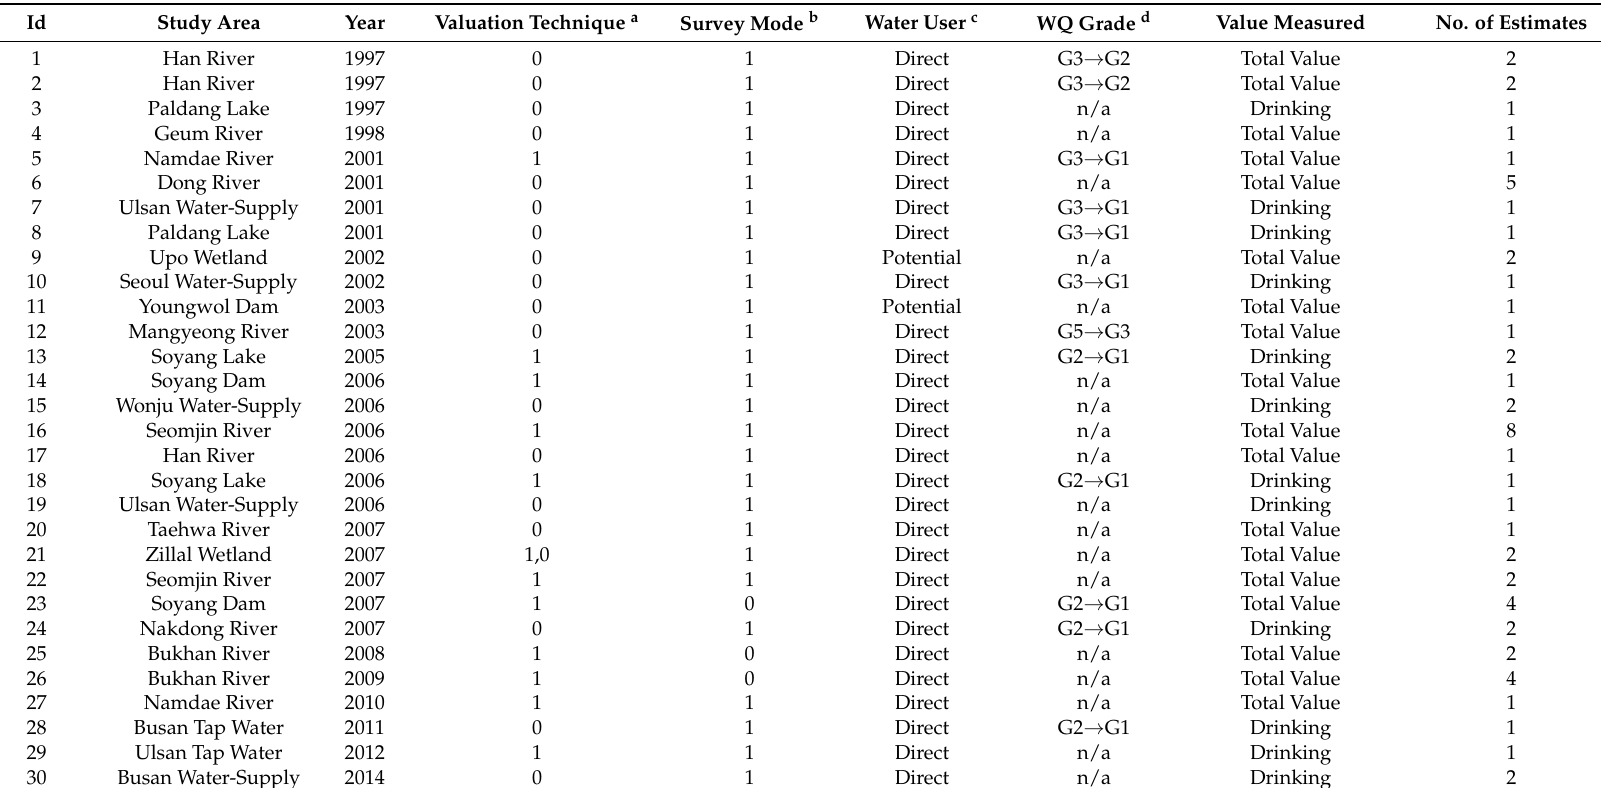
Table A1. The list of original studies used in meta-regression